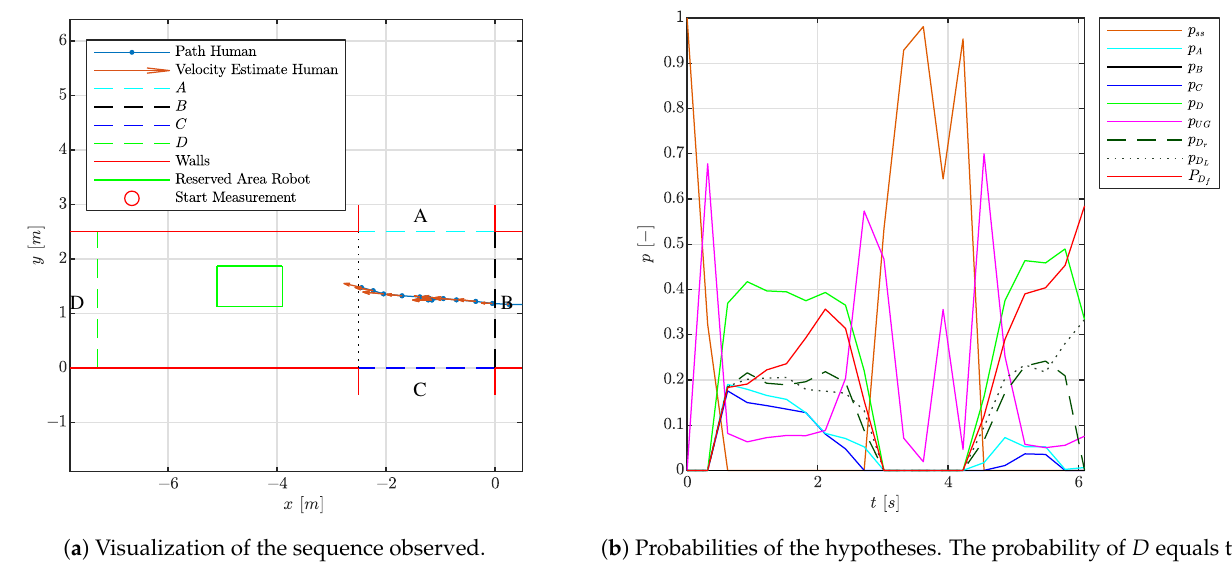
( b ) Probabilities of the hypotheses. The probability of D equals the sum of the probability of passing the robot on the left or right side. Figure 7. Visualization of the experiment where a person enters the crossing, waits for a moment and continues its route in forward direction.